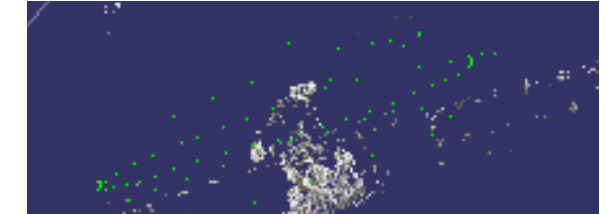
Figure 14. Results of